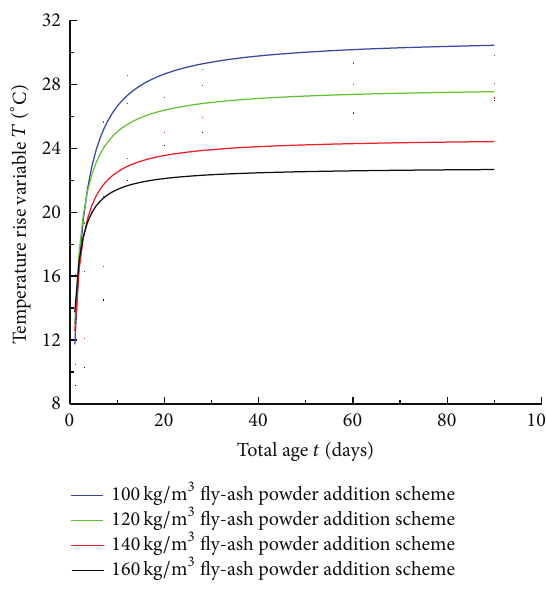
Figure 14: Theoretical temperature rise procedures based on updated hyperbolic model.